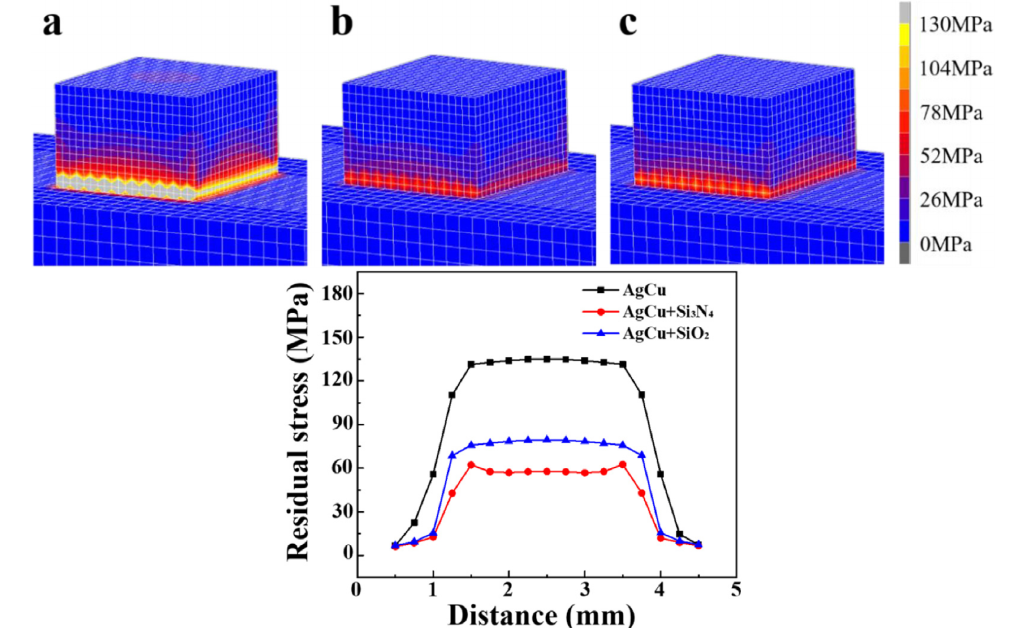
Figure 9: Distribution of equivalent Von Mises stress in joints brazed with (a) pure AgCu, (b) AgCu+Si 3 N 4 , and (c) AgCu+SiO 2 , and residual stress distribution of the middle cross-section in C/C composites.